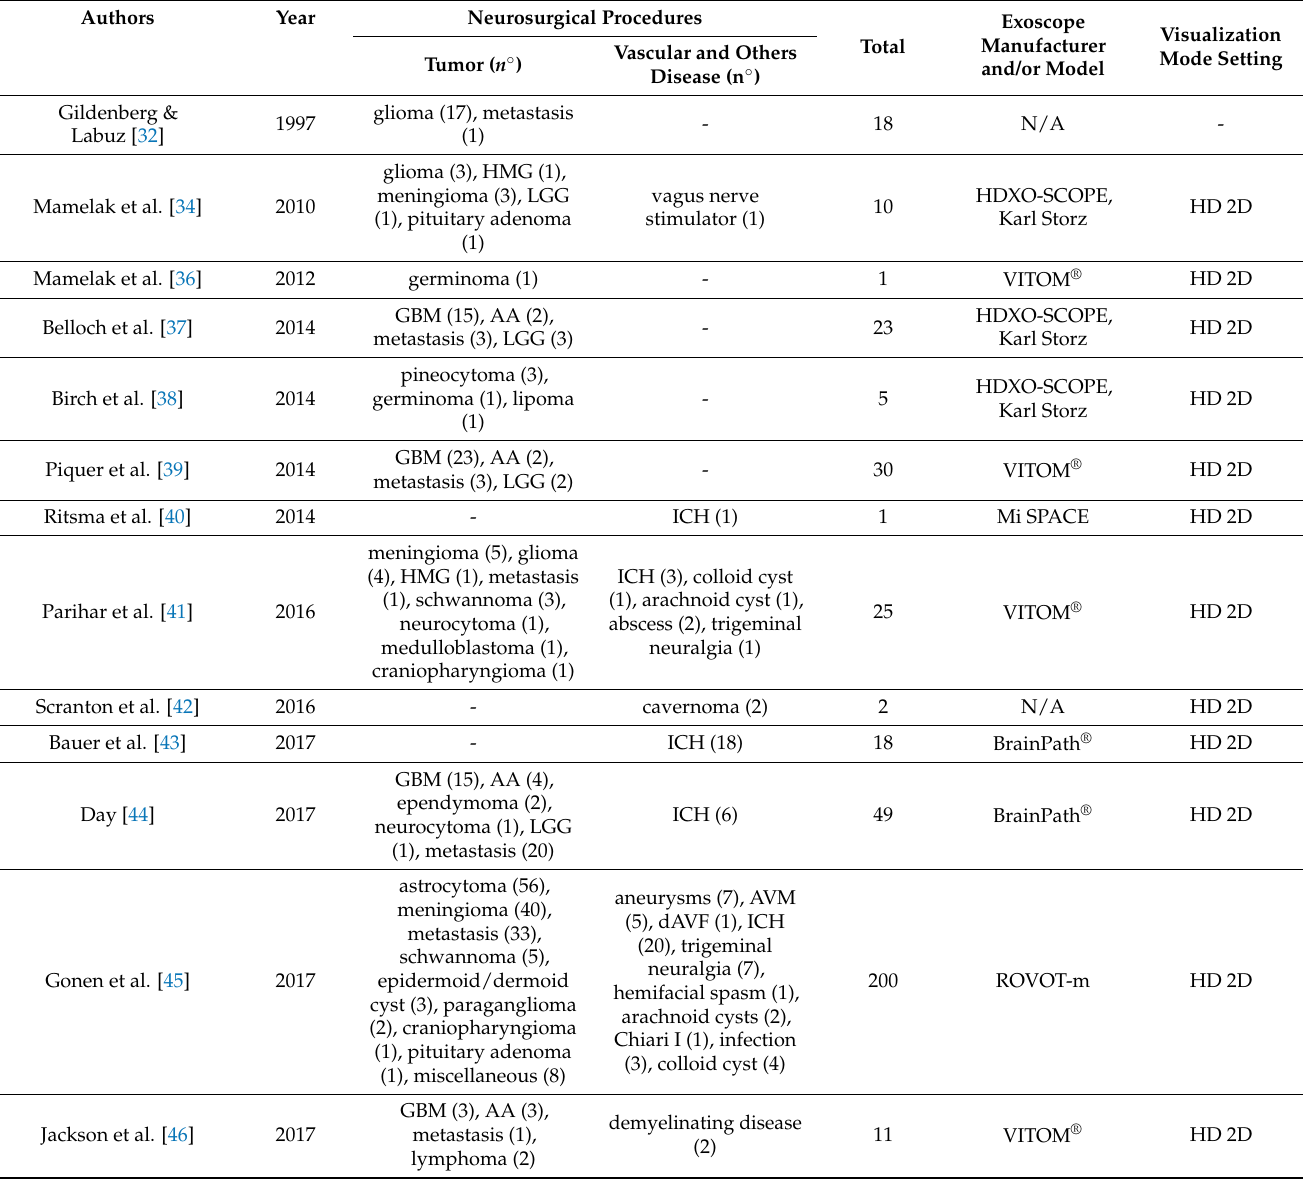
Table 2. Summary of cranial studies included in the